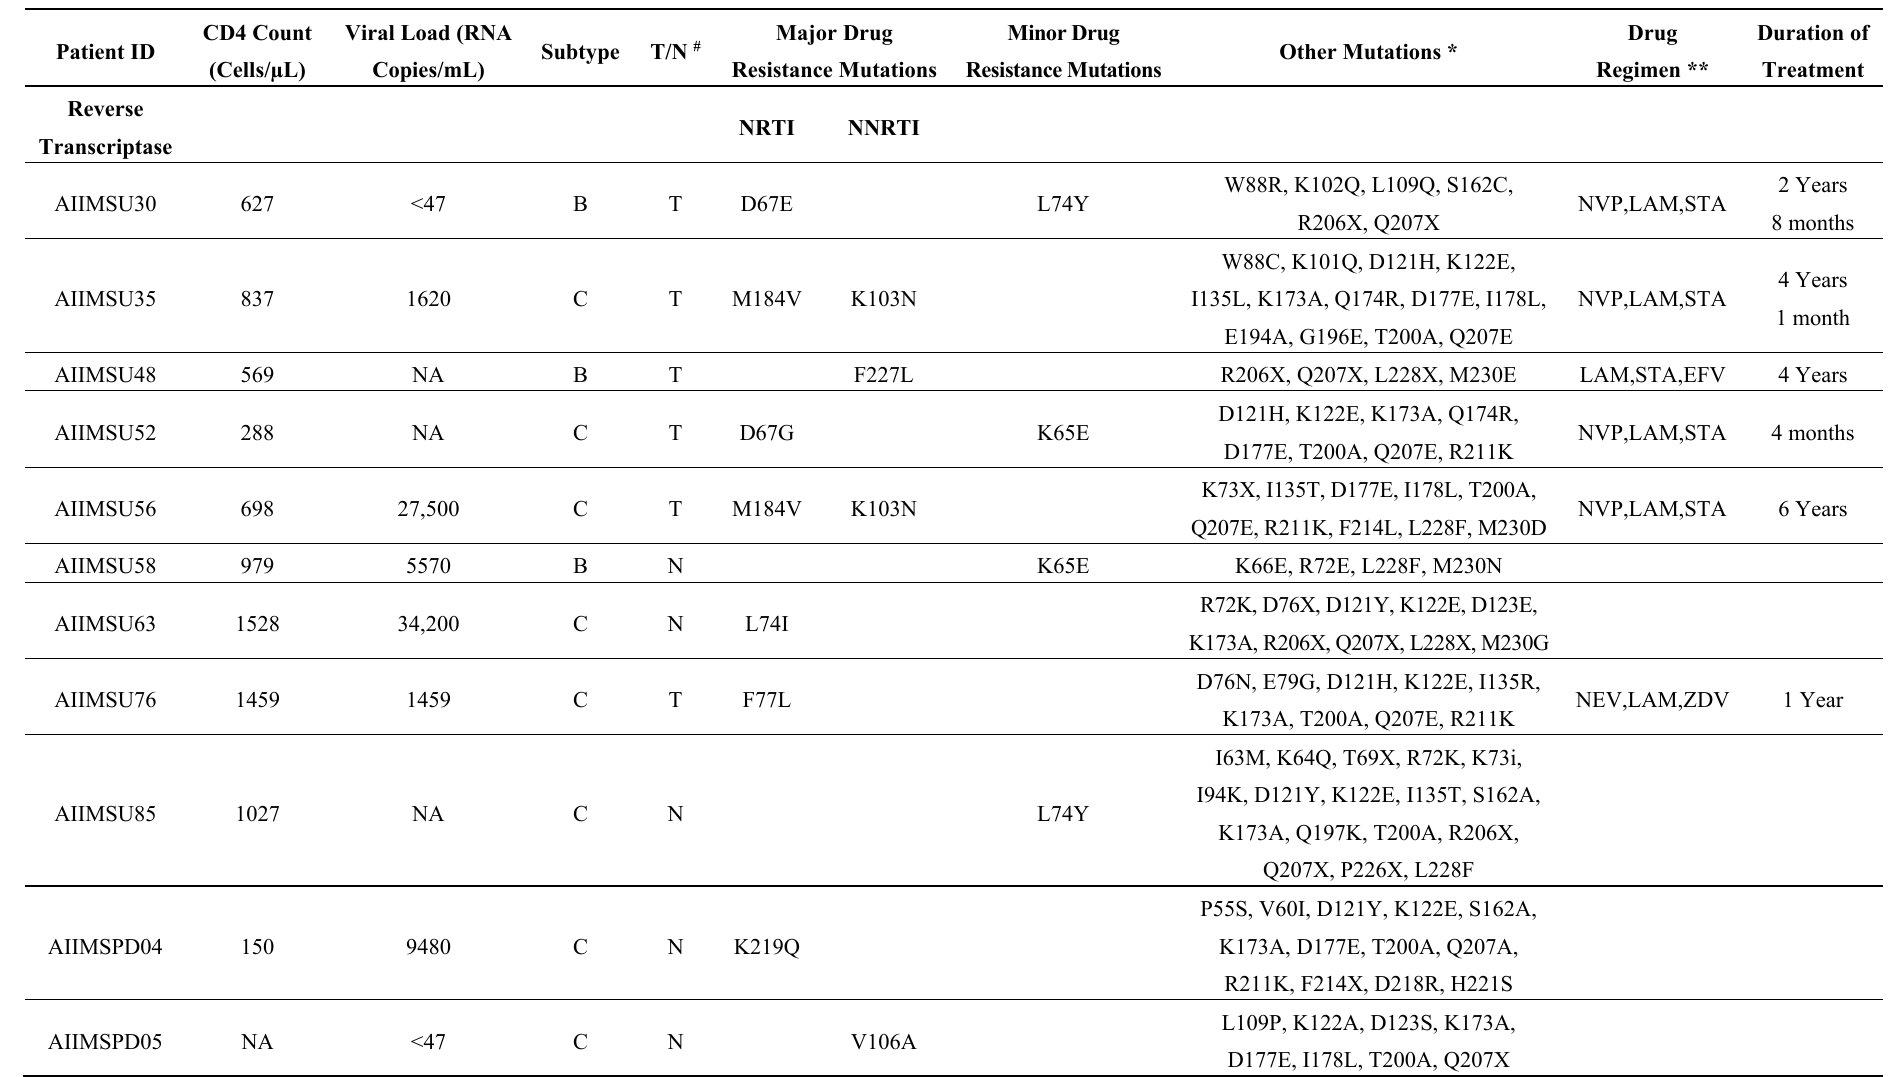
Table 3. Overview of the RT and PR resistance associated mutations in ART naïve and treated HIV-1 infected